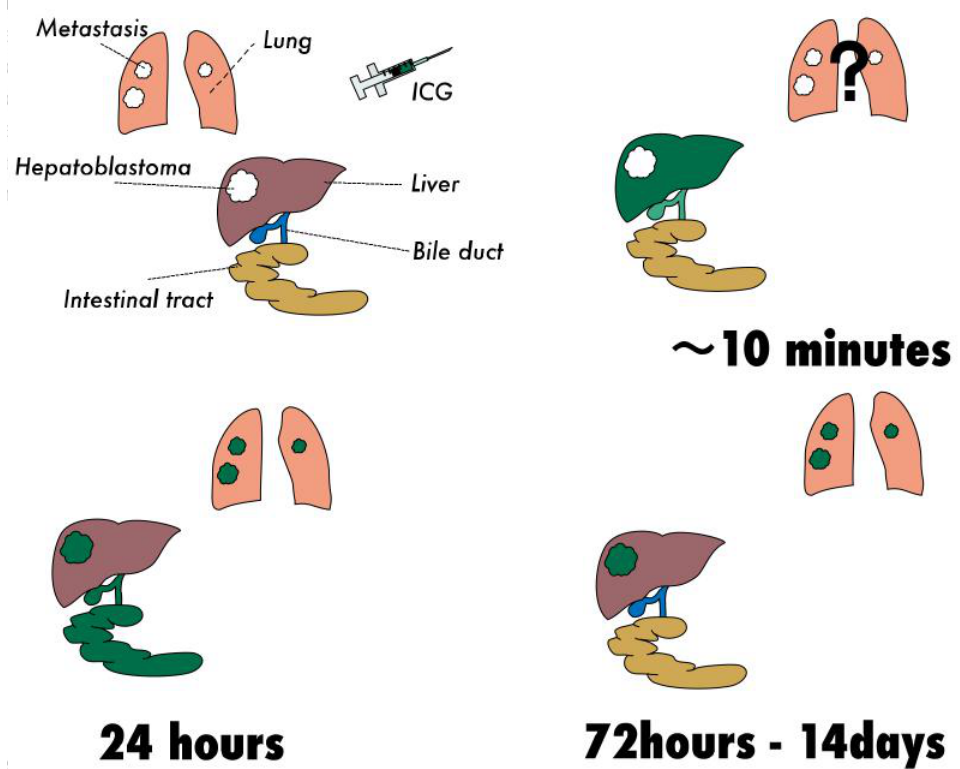
Figure 8. ICG is distributed to the whole body and accumulates in the liver (within a few minutes after the intravenous injection). ICG is then excreted into the biliary system and persists for up to 20–24 h. While liver tumors display non-fluorescent spots in NIR mode at a very early stage after the injection of ICG, such studies have not been performed in lungs with metastatic HBs. The selective retention of ICG can be observed in HBs in both the liver and lungs around 24 h, but excreted fluorescence remains in the bowel loops. By 72–96 h after the injection, bowel-retained ICG is excreted with feces. HB tissues retain ICG for up to two weeks. The pattern of fluorescence may vary depending on the dose of ICG, detecting device, liver function, and